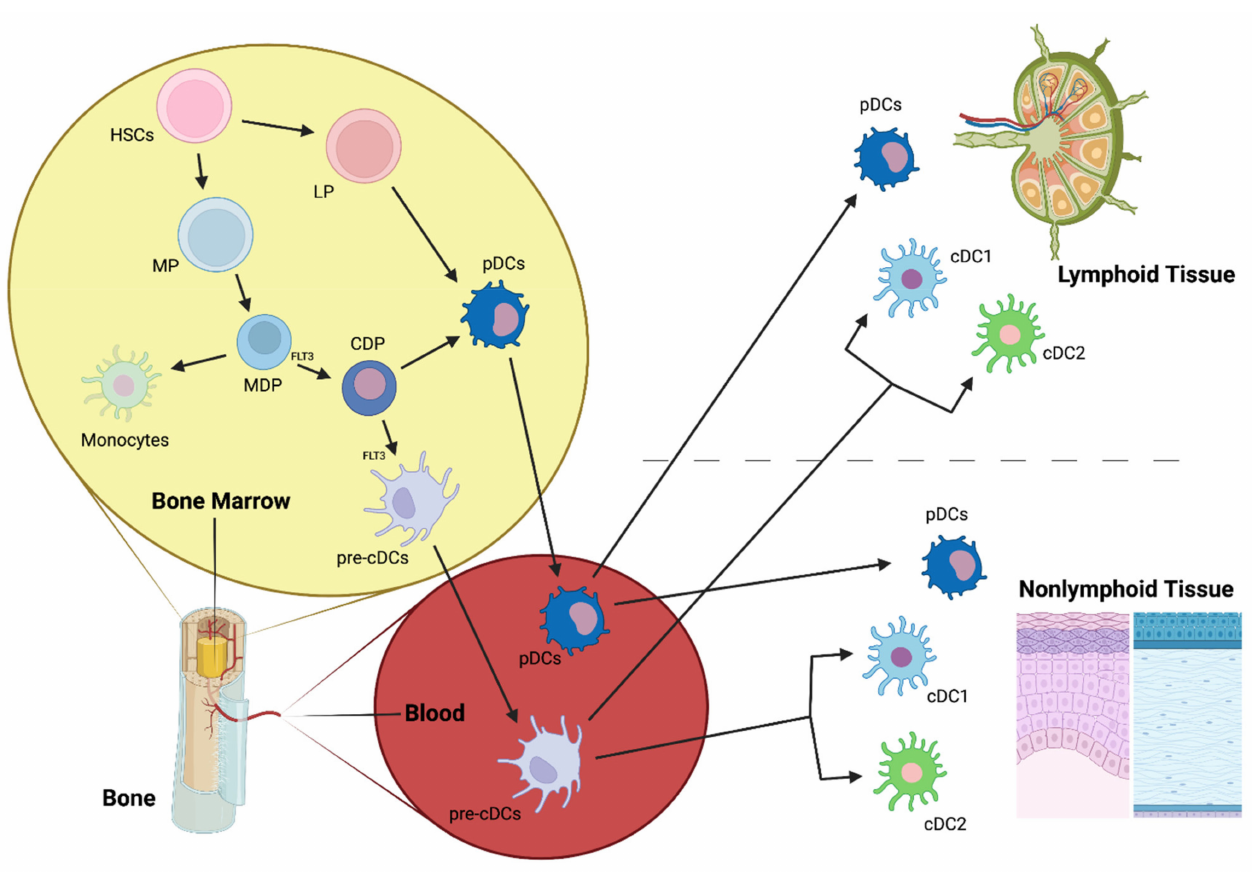
Figure 4. cDC1 and cDC2, main conventional dendritic cell subtypes; CDP, common DC precursor; FLT3, Fms-Related Tyrosine Kinase 3; HSCs, hematopoietic stem cells; LP, lymphoid precursor; MDP, macrophage-DC precursor; MP, myeloid precursor; pre-cDCs, pre-classical dendritic cells; pDCs, plasmacytoid dendritic